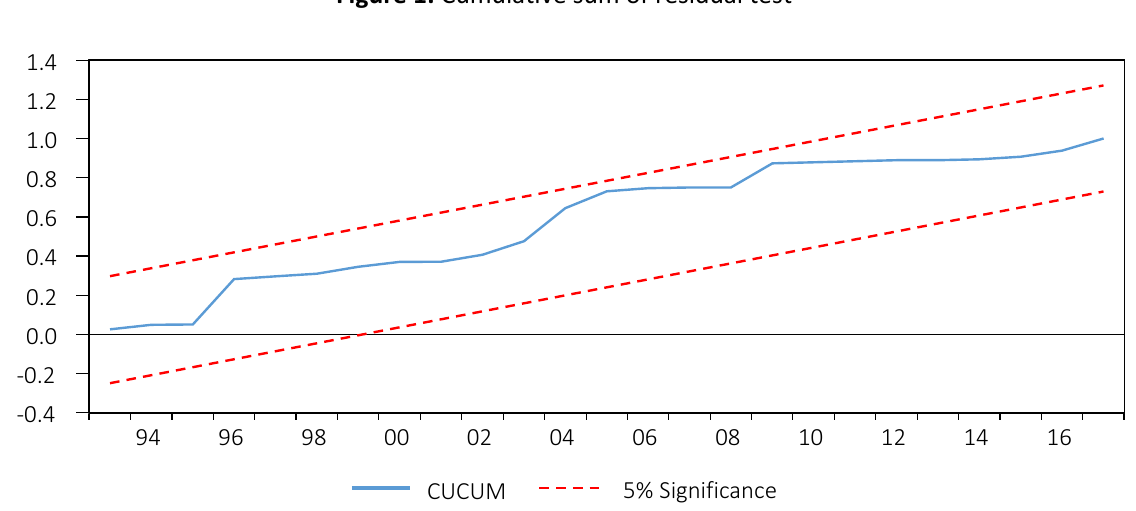
Figure 1. Cumulative sum of residual test